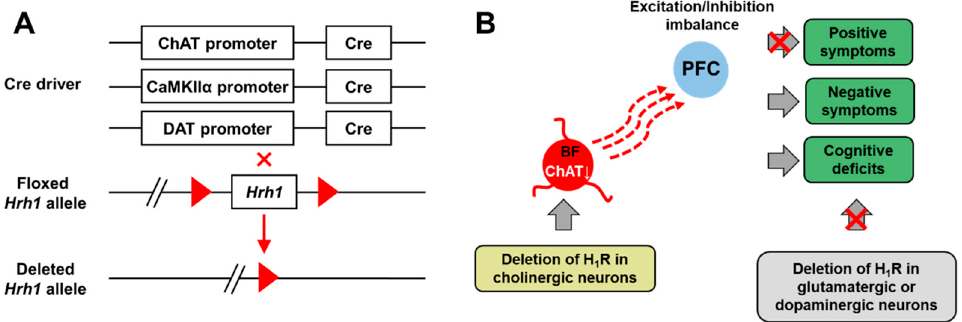
Figure 2. H 1 R in basal forebrain (BF) cholinergic neurons plays a critical role in the pathogenesis of negative symptoms in schizophrenia. ( A ) Schematic diagram of the generation of conditional knockout mice. ( B ) Schematic diagram of the working model [87]. BF, basal forebrain; PFC, prefrontal cortex.